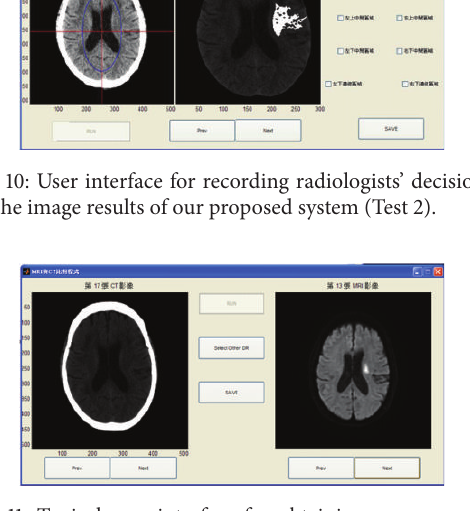
Figure 11: Typical user interface for obtaining an assessment by a professional radiologist. The left side shows a stroke patient CT image and the right side shows the corresponding MRI image of the same